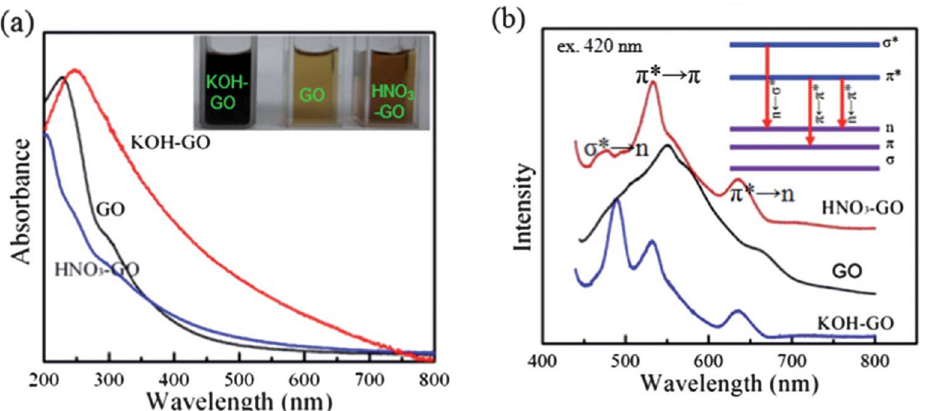
Figure 1. ( a , b ) Absorption and emission spectra of GO treated with KOH and HNO 3 in water ( λ ex. = 420 nm). Inset: energy level diagram for multiple electronic transitions. Reprinted from [32] with permission from Wiley.